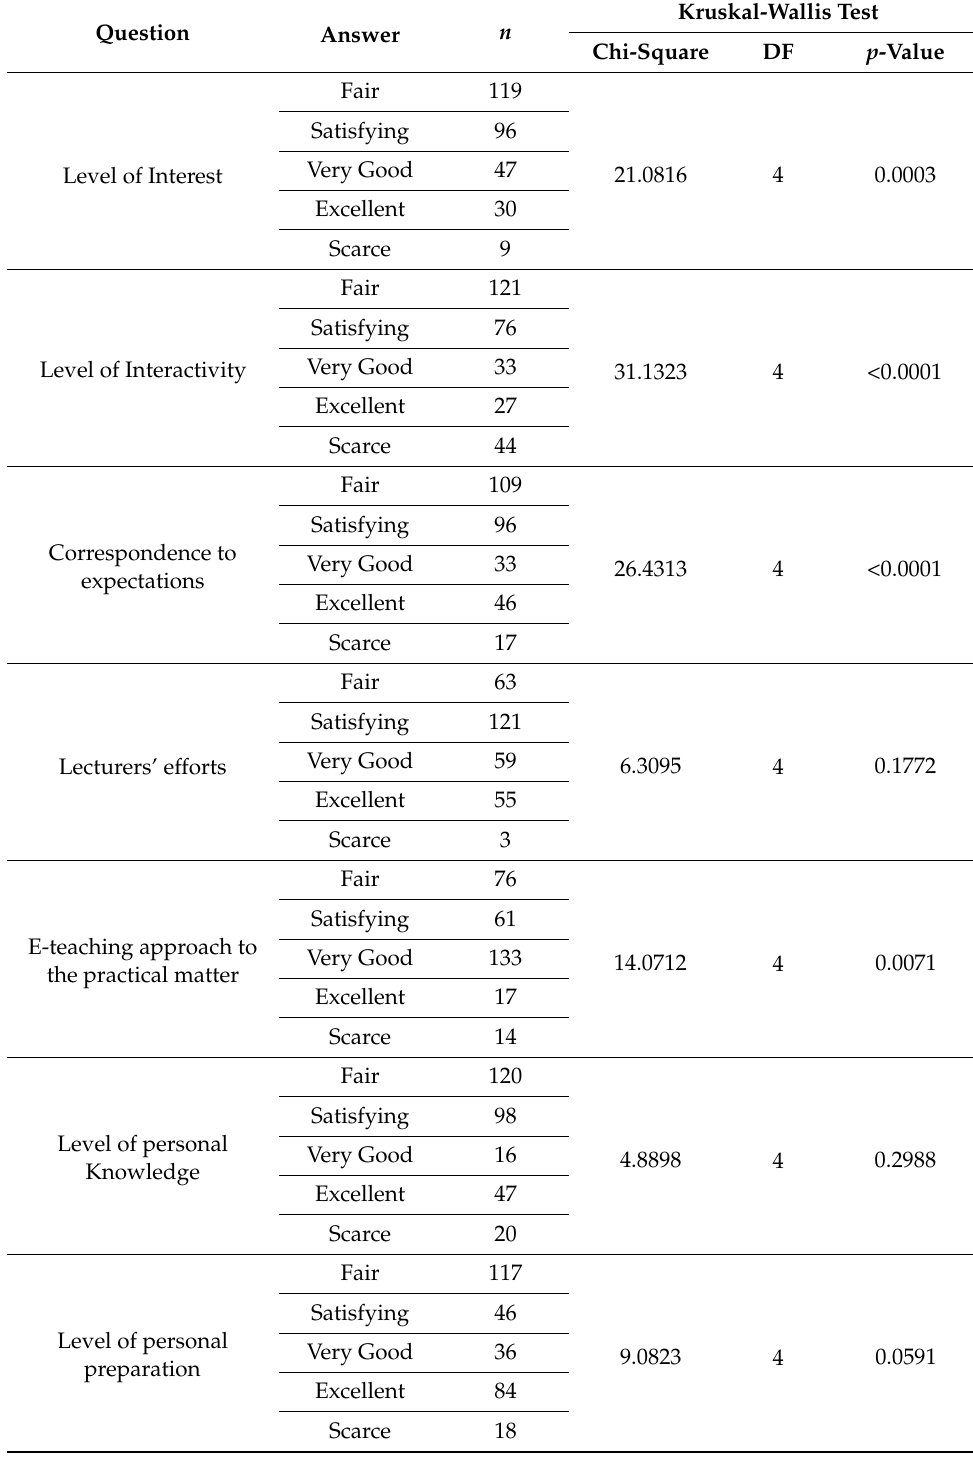
Table 2. Kruskal–Wallis test results. The dependent variable was the year of